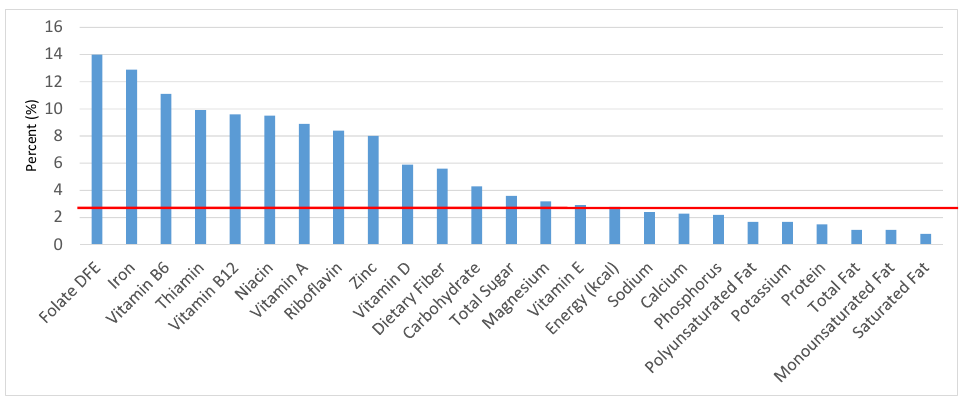
Figure 15. Ready ‐ to ‐ eat cereals as sources of energy and nutrients for adolescents 14–18 years old ( N = 1508, daily intake data): DFE = Dietary Folate Equivalents; solid red line represents percentage of energy (kcal) provided in the diet relative to nutrients—nutrients above the red line show the grain food’s contribution to nutrient density.